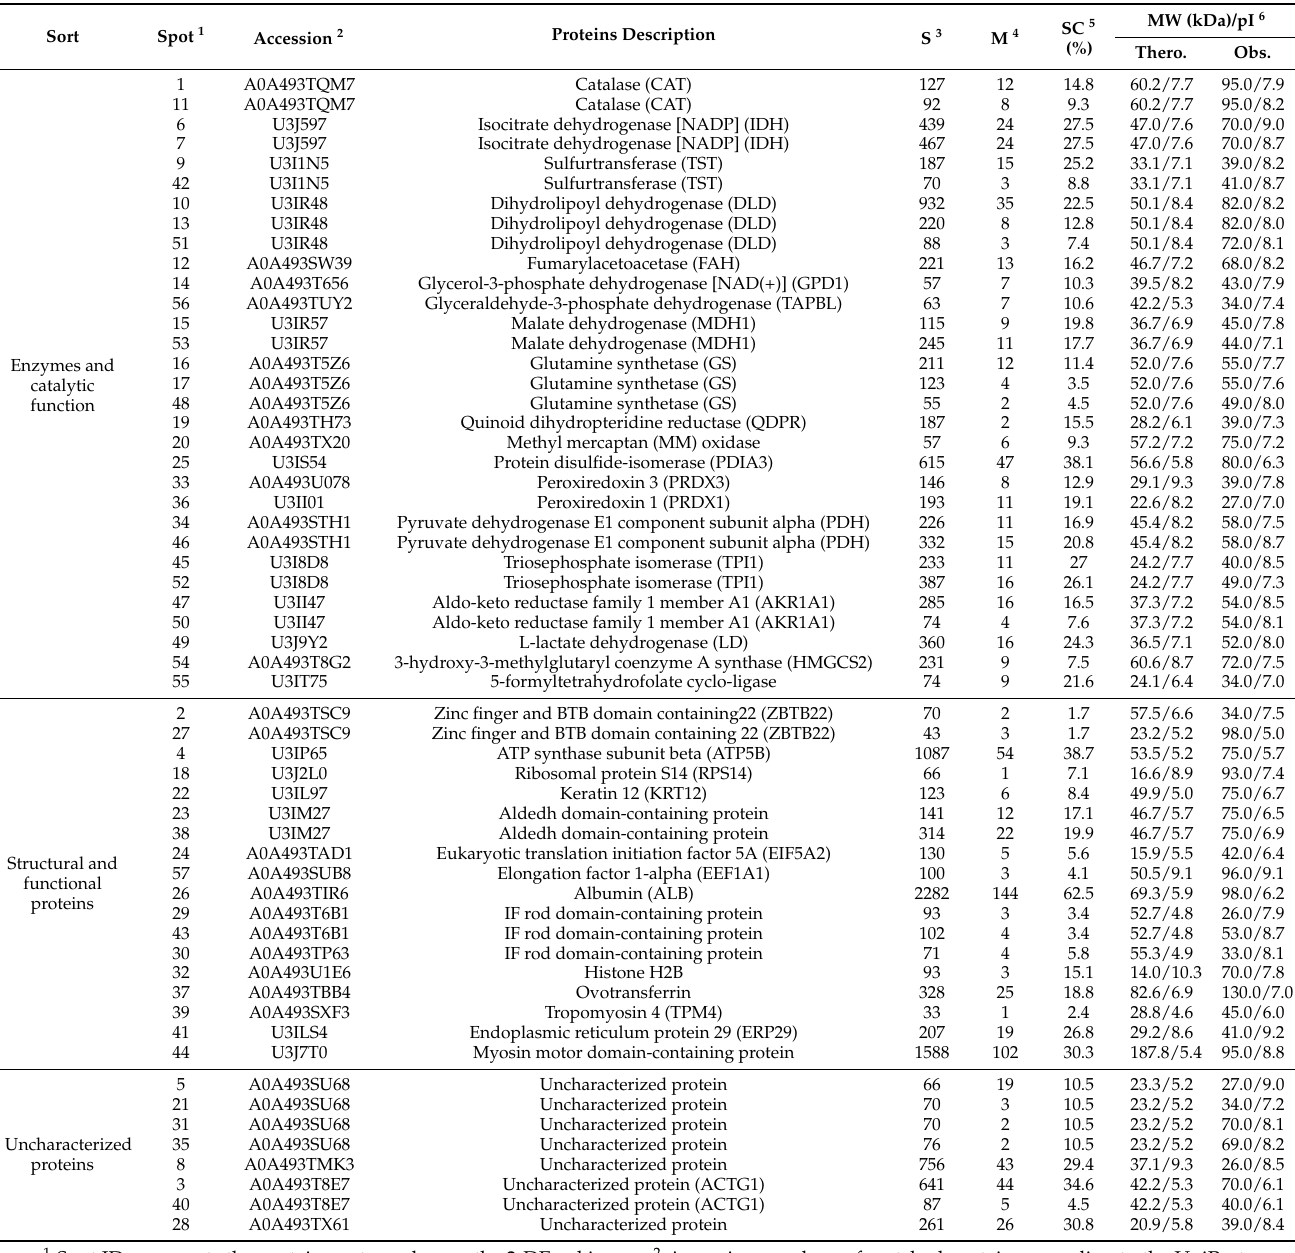
ranking protein hits. 4 Matched, matched peptides for the number of pairings in an experimental fragmentation spectrum to a theoretical segment of protein. 5 Sequence coverage (%), the ratio of the number of amino acids in every peptide that matches with the mass spectrum in the total number of amino acids in the protein sequence. 6 Theoretical molecular weight (MW) and isoelectric point (pI) of the identified proteins retrieved from the UniProt protein